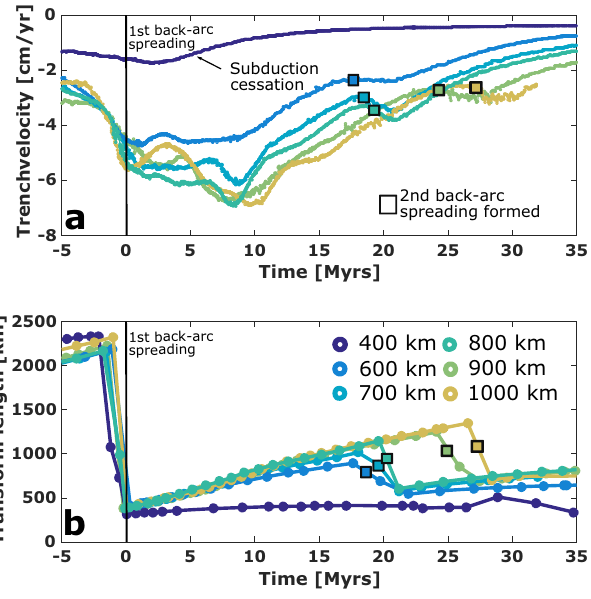
Fig. 3 Temporal evolution. a Trench velocities and b transform fault lengths for models with various plate widths. Model times are relative to the fi rst back-arc basin opening. Opening of back-arc basins increase rollback rates (i.e. negative trench velocities) temporally. While the overriding plate and transforms grow with ongoing rollback, rollback rates decrease. Spreading jumps are displayed in the suddenly decreased transform length. Subduction ceases in the 400 km model, as well as in the 600 km model after the back-arc spreading centre jump, due to the inability to tear through lithosphere at plates interfaces (see Supplementary Information).